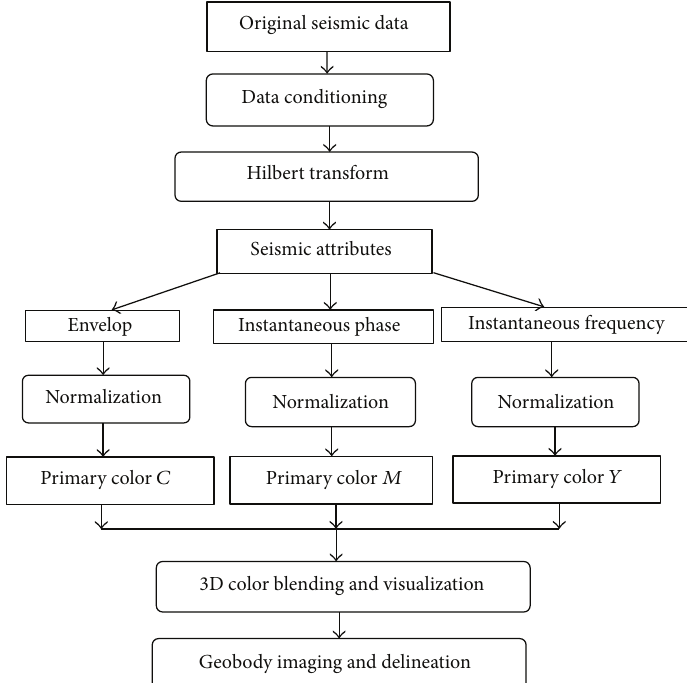
Figure 4: CMY color blending workflow for subsurface geobody